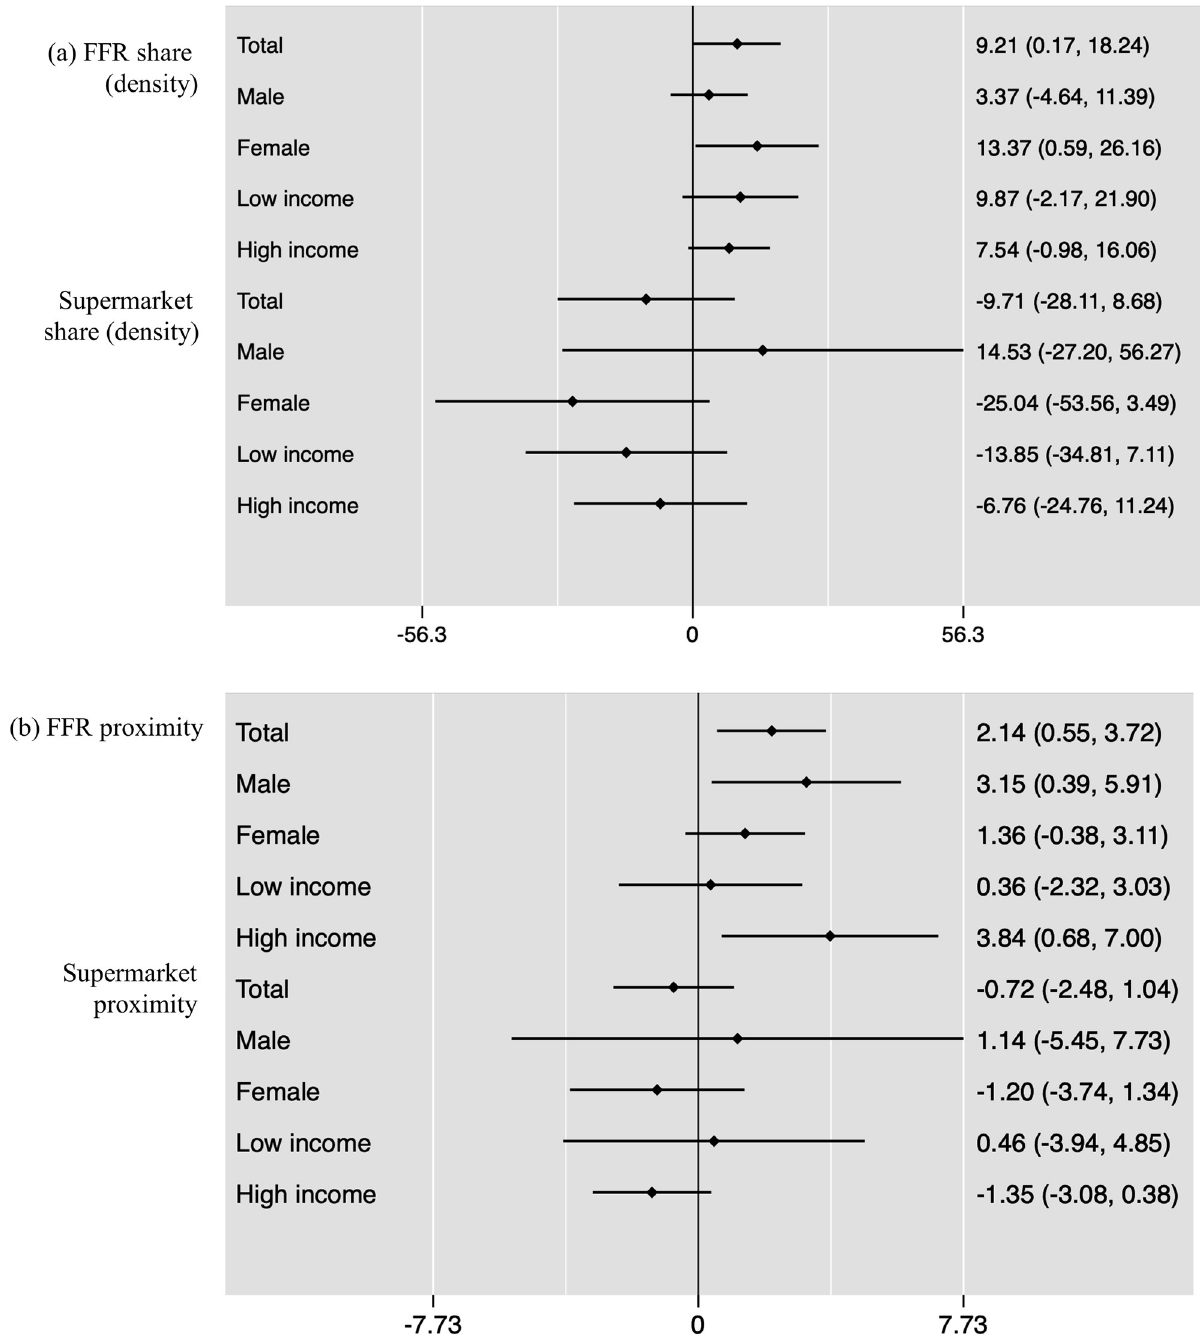
Fig 1. Associations between fasting blood glucose level and density (a) and proximity (b) of food outlets. Note: The values show OLS regression coefficients; 95% CIs in brackets. Density = the number of each food outlet per total number of food outlets within 300 m of a resident’s home address. Proximity = 1 if having at least 1 outlet within 100 m of a resident’s home address and 0 if otherwise. FFR, fast-food restaurant; OLS, ordinary least squares.